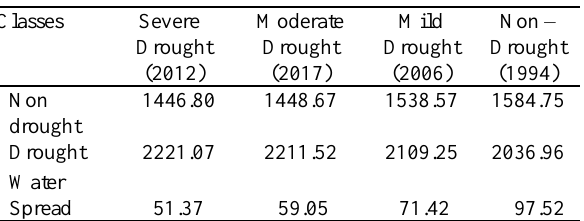
Table 3. Area under non-drought, drought and water bodies (in